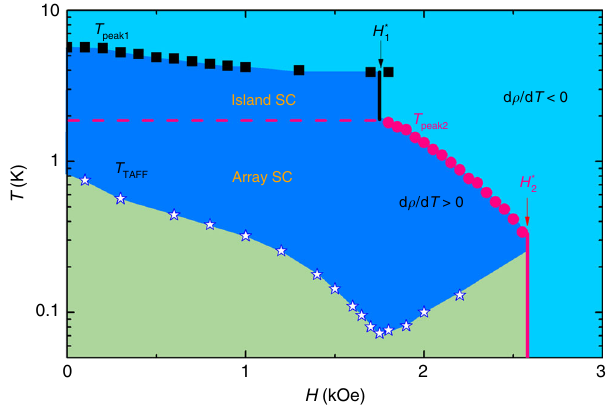
Fig. 5 H – T phase diagram for the graphene-tin nanoislands array hybrid. The T peak1 (black square), T peak2 (red pink circle), HTCR (black solid line), and LTCR (red pink solid line) separate the superconductivity region (d ρ / d T > 0) and the weakly localizing metal region (d ρ / d T < 0). T TAFF points, which correspond to the black arrows in the Arrhenius plot (Supplementary Figure 15), de fi ne the boundary between the thermal activation region and the quantum tunneling vortex region. Intra Island SC and Inter Island SC denote the intra-tin nanoisland superconductivity and the inter-tin nanoisland superconductivity,